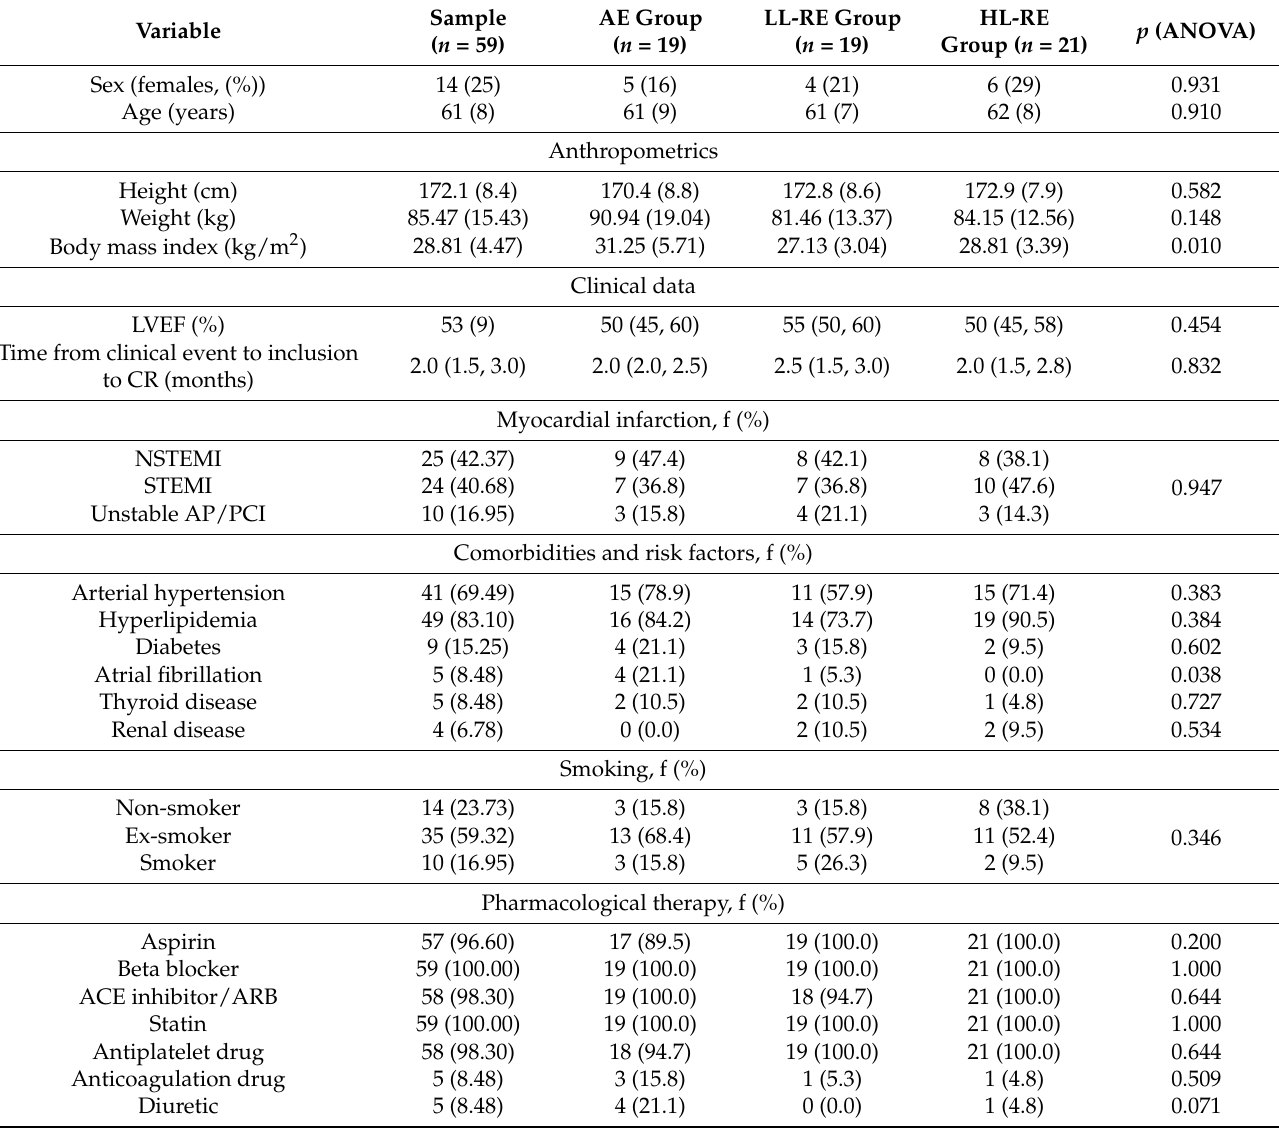
Table 2. Baseline sample demographic, anthropometrical and clinical